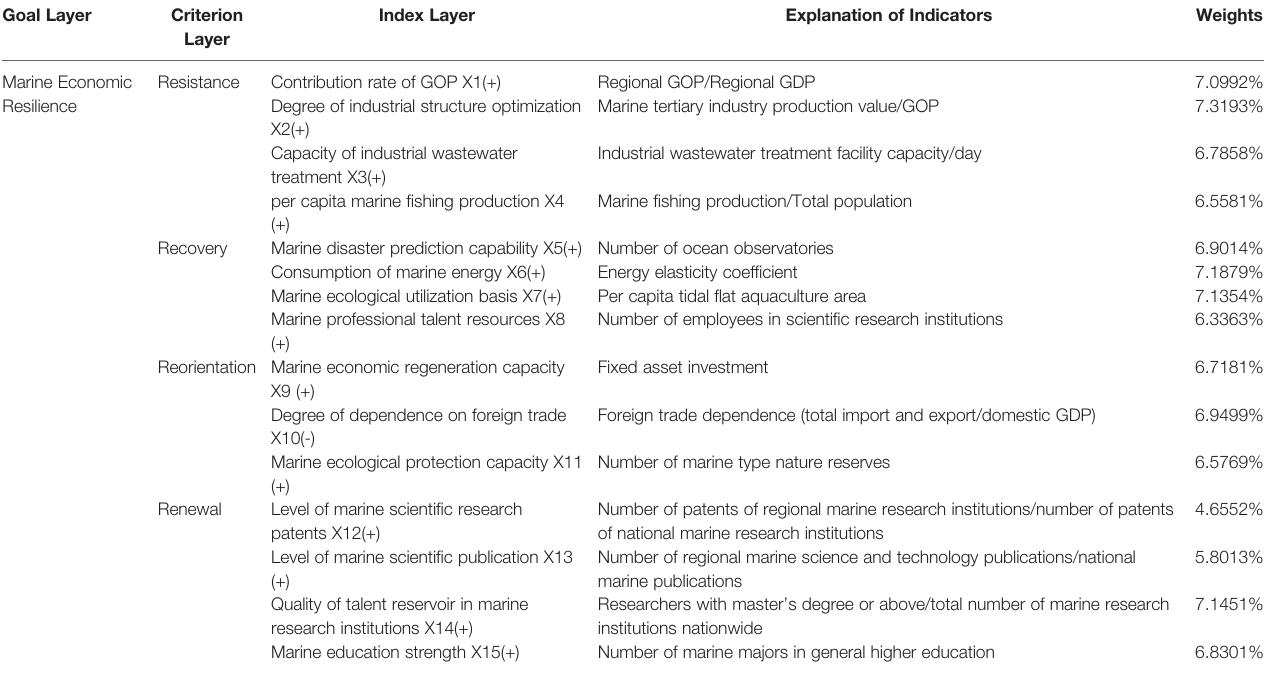
TABLE 2 | Marine economic resilience indicator